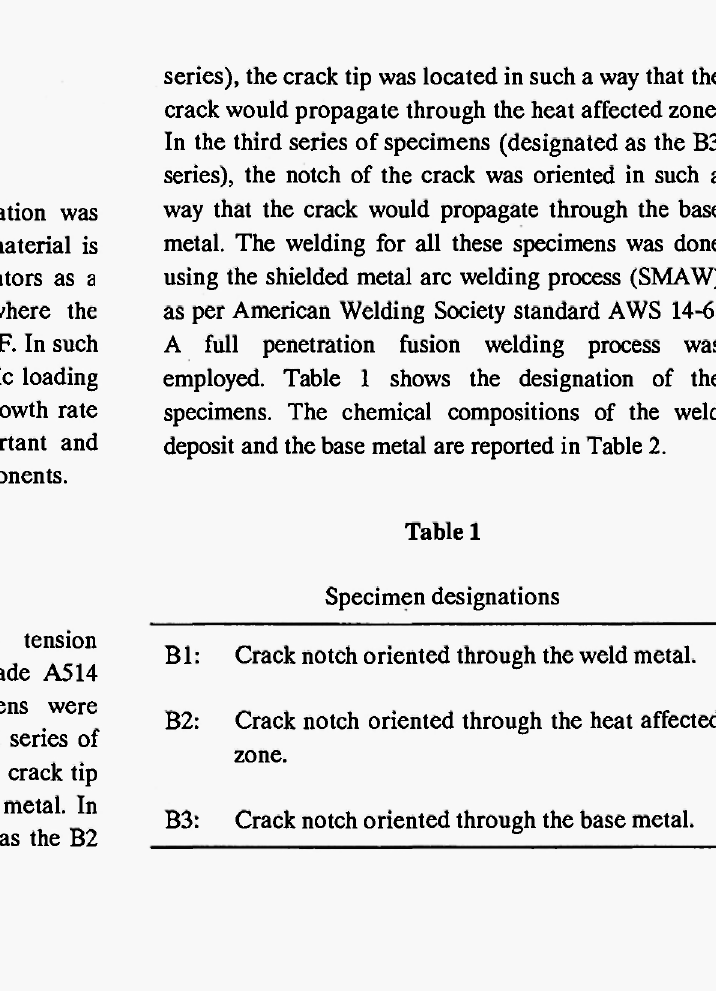
Fig. 1: Schematic representation of fatigue crack growth according to Paris